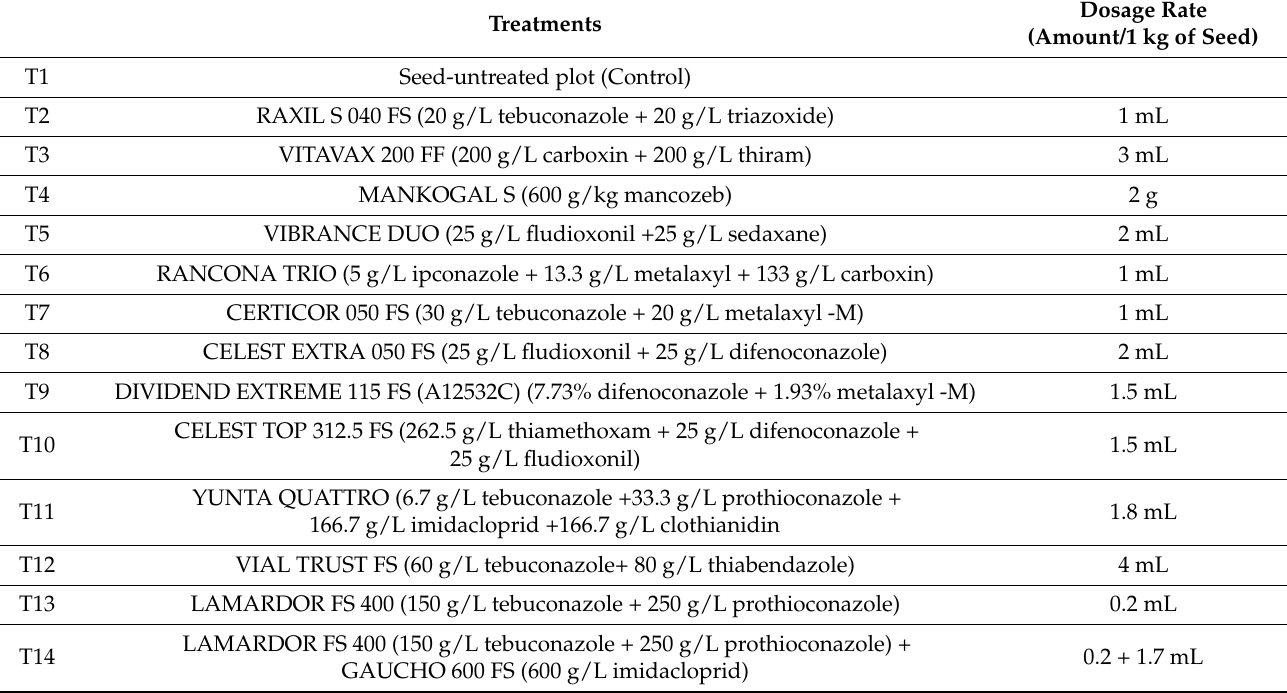
Table 2. Fungicide treatments in research and development trials on fungicide efficacy against U. nuda and P. graminea